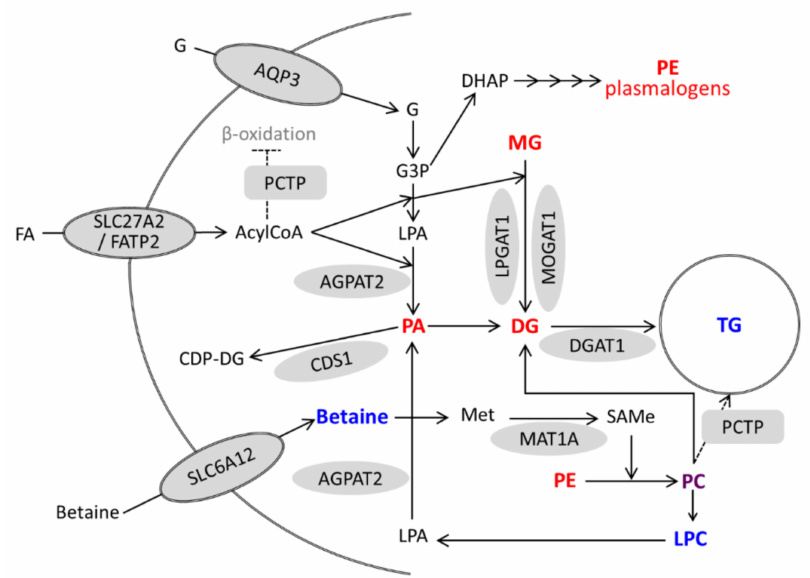
Figure 9. A model for the regulation of lipid metabolism in hepatocytes by activated VDR. Genes upregulated by VitD / VDR are represented by grey forms. Metabolites with increased and decreased levels after VitD are in blue and red, respectively. Phosphatidylcholine (PC) is represented in purple because some species increased and others decreased. G, glycerol; G3P, glycerol-3-phosphate; DHAP, dihydroxyacetone phosphate; FA, fatty acid; LPA, lyso-phosphatidic acid; and Met,